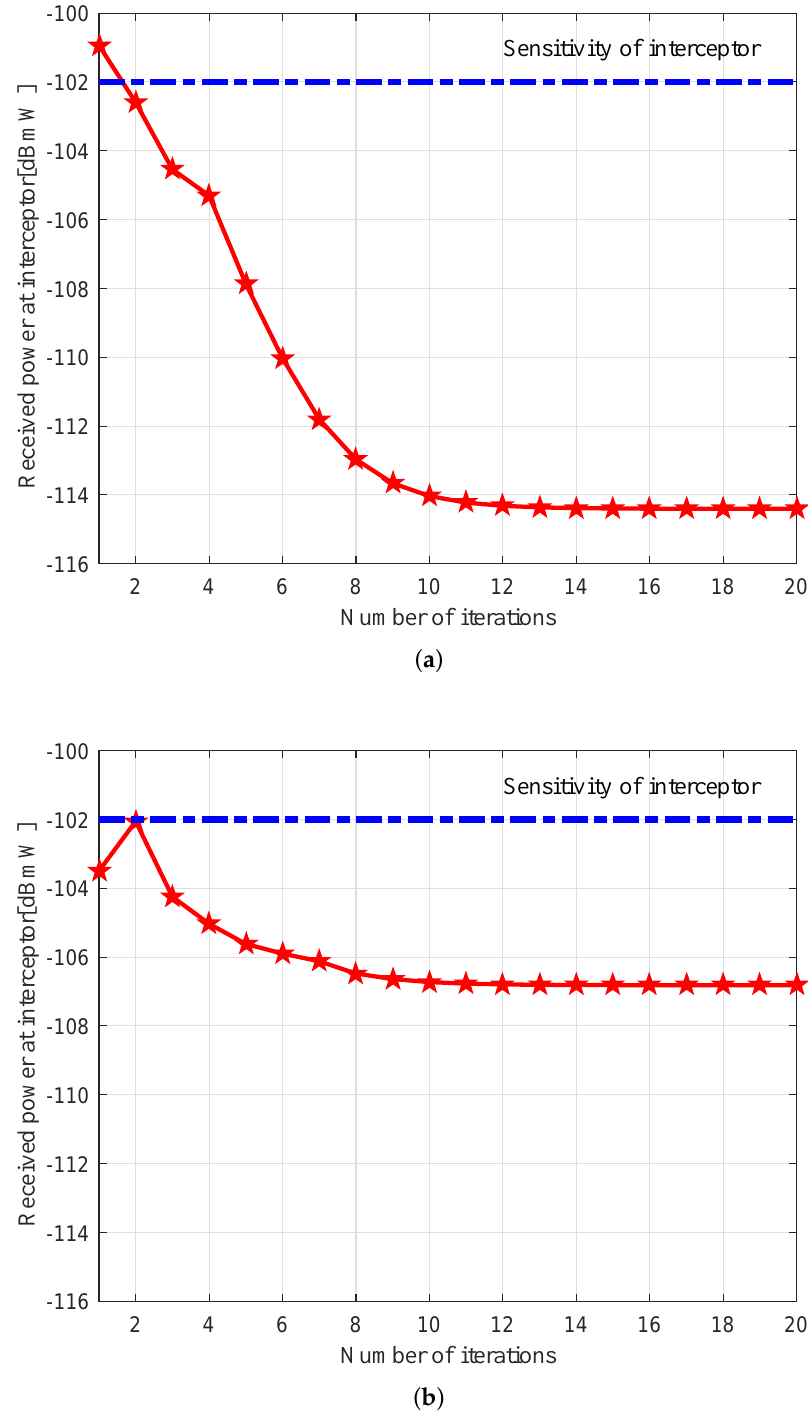
Figure 11. Convergence behavior for the received power at intercept receiver in the second case: ( a ) Target position is [ 0,0 ] km; ( b ) Target position is [ − 30, − 40 ]